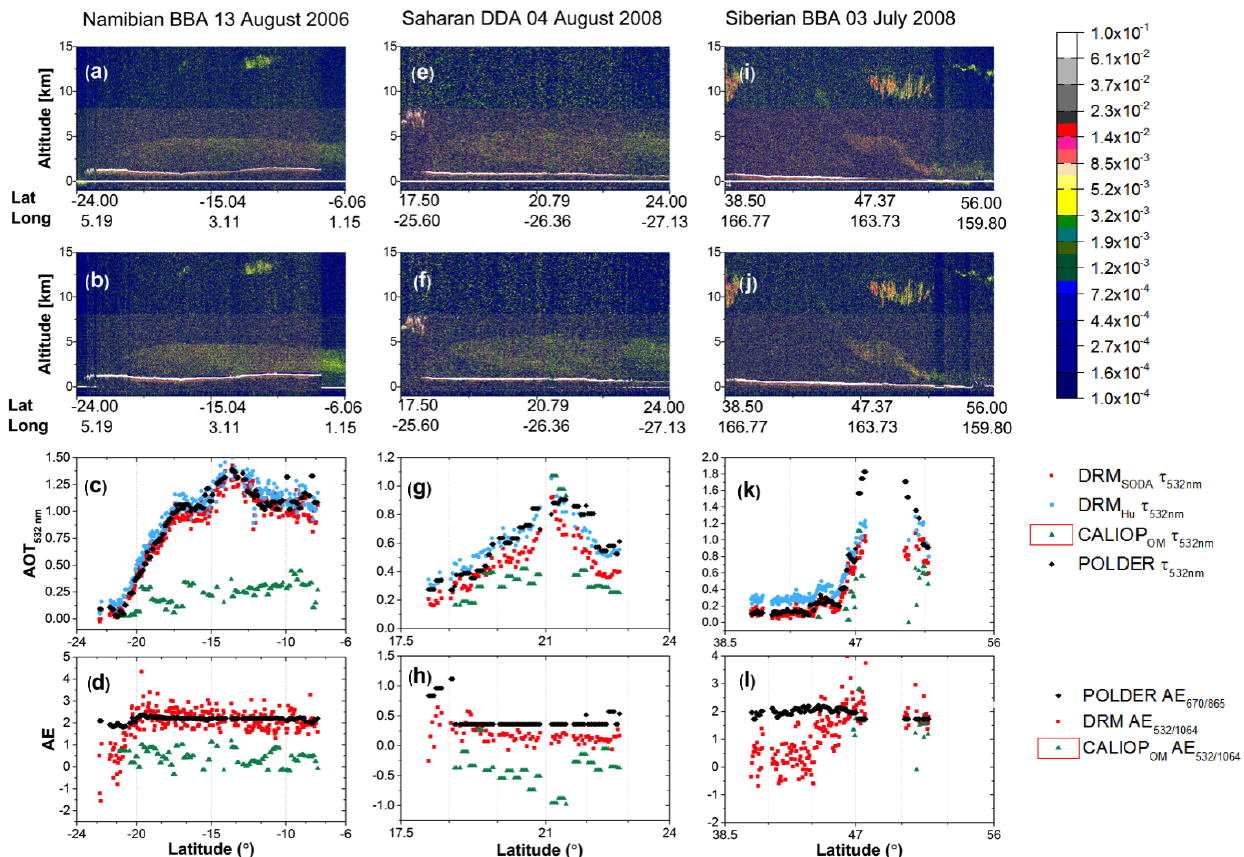
Figure 1. The first row of the panel shows the lidar CALIOP attenuated backscatter coefficients at 532nm (km − 1 sr − 1 ) and the second row presents the CALIOP attenuated backscatter coefficients at 1064nm for three case studies: African biomass-burning aerosols (BBA) above clouds on 13 August 2006 (a–d) , Saharan dust (DDA) on 4 August 2008 (e–h) and Siberian biomass-burning aerosols over the Okhotsk Sea on 3 July 2008 (i–l) . For these cases, the above-cloud AOT at 532nm and the Ångström exponent (AE) as a function of latitude, measured with several techniques, are